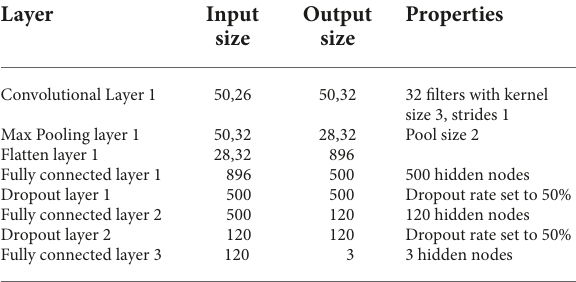
TABLE 1 Input and output shapes of the Convolutional Neural Network of this study. Layer